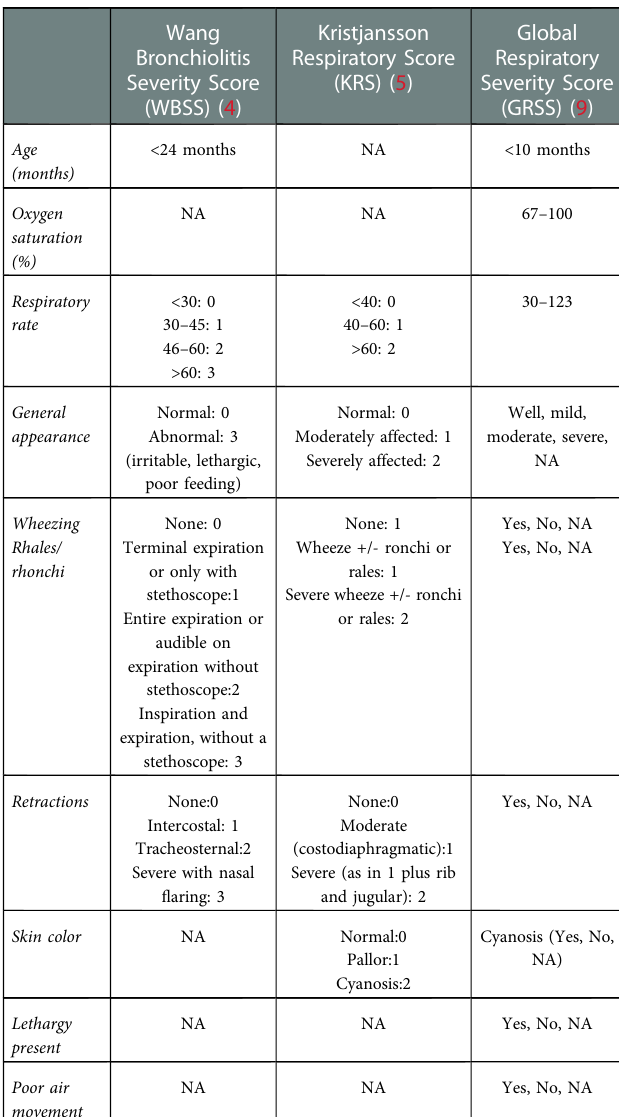
TABLE 1 Parameters of each scoring